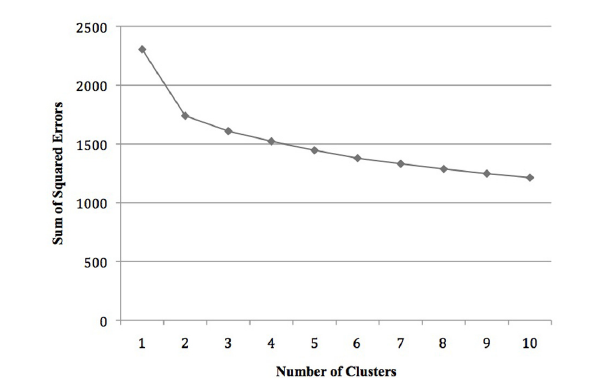
FIGURE 1 | Heterogeneity measures across the final 10 fusion steps ( n =